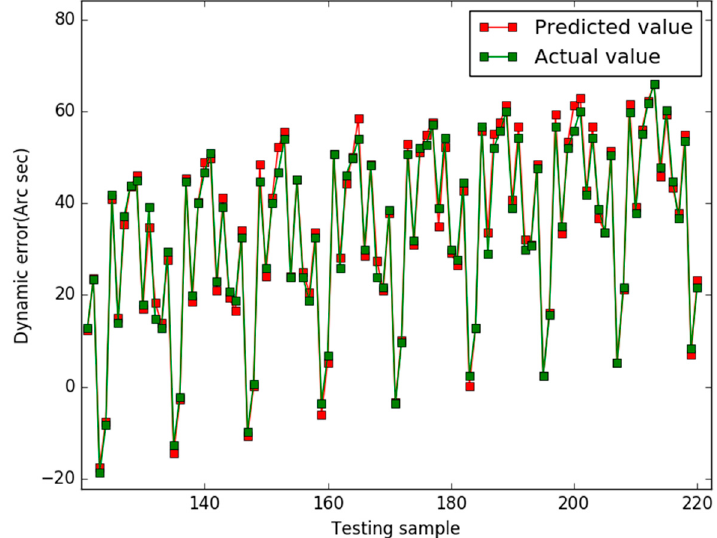
Figure 1. Predicted results of the NAPSO-SVM (case 1).